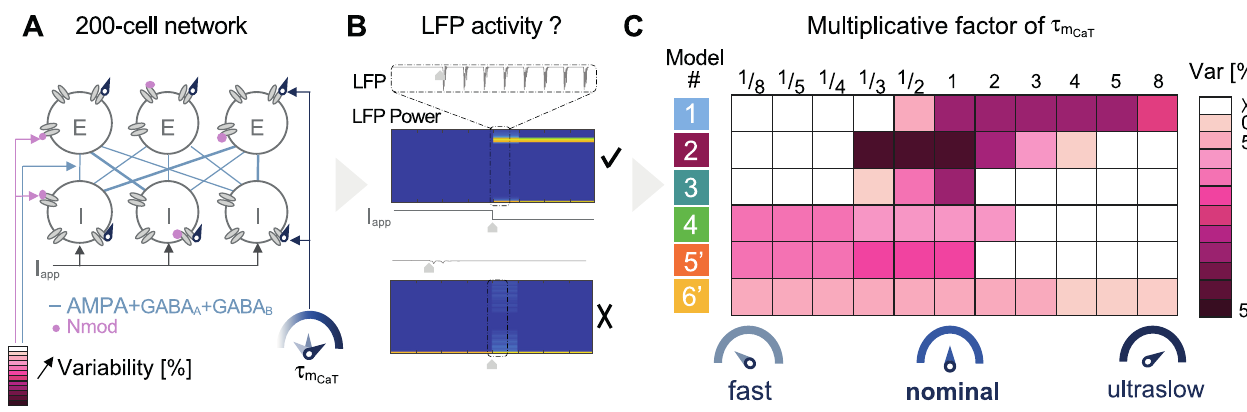
Fig 5. Comparison between fast, slow or ultraslow T-type calcium channel activation in generating robust mean-field activity transition. A : A 200-cell network with 100 excitatory neurons and 100 inhibitory neurons connected via AMPA, GABA A and GABA B synapses under the control of an hyperpolarizing current. The intrinsic and extrinsic parameters are respectively affected by neuromodulation and synaptic plasticity; their values are randomly picked in a given interval (namely variability). The CaT channel activation time constant t of each neuron is scaled by a multiplicative factor. B : At each scaled time constant, m CaT we check if the heterogeneous network is switching by analyzing the LFP activity. If the LFP timecourse presents a strong activity and its spectrogram shows a marked power band, the network displays an oscillatory state during the hyperpolarization state. C : The table summarizes the largest variability width at which the network presents a switch in its mean-field activity for several scaled time constants. Respecting the slow timescale of the CaT channel activation guarantees the switch in network rhythm compatible with variability in channel densities and synaptic weights. Driving the CaT channel activation to a fast or ultraslow timescale makes models more fragile to network topology and